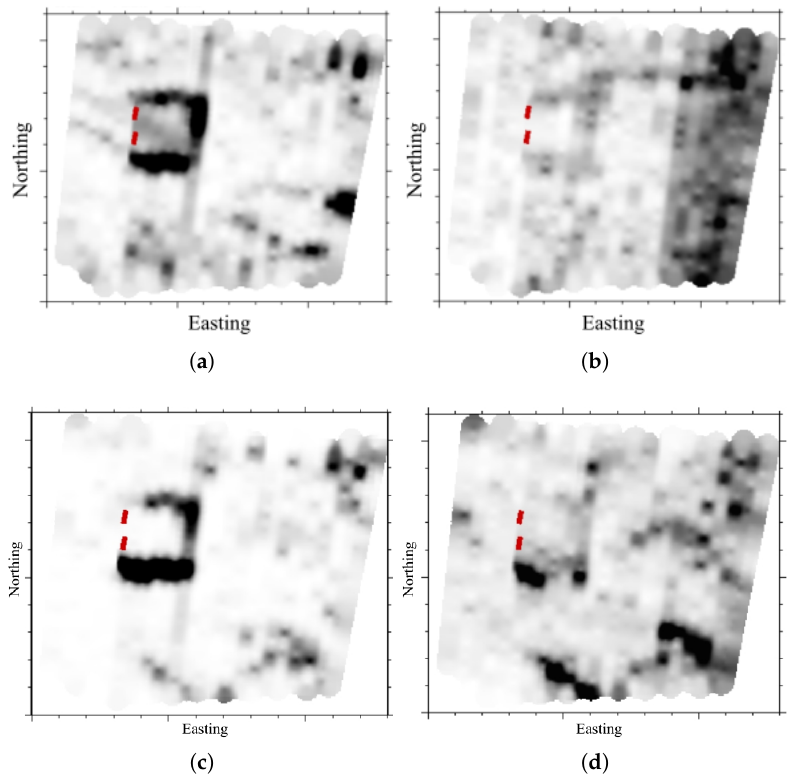
Figure 3. Side-by-side depth slice comparisons. ( a ): Relying on a mean trace removal used to remove the direct wave, the response from the railroad ties in the shallowest depth slice is apparent. ( b ): Direct wave and response of railroad ties removed through SVD-filtering. ( c ): At 0.5 m in depth the ringing is still apparent but combined with a shallow anomaly beneath the southern edge of the railroad ties. ( d ): With the ringing removed, the shallow features can be resolved. ( a ) Mean trace removal, 0 m depth. ( b ) SVD filtered, 0 m depth. ( c ) Mean trace removal, 0.5 m depth. ( d ) SVD filtered, 0.5 m